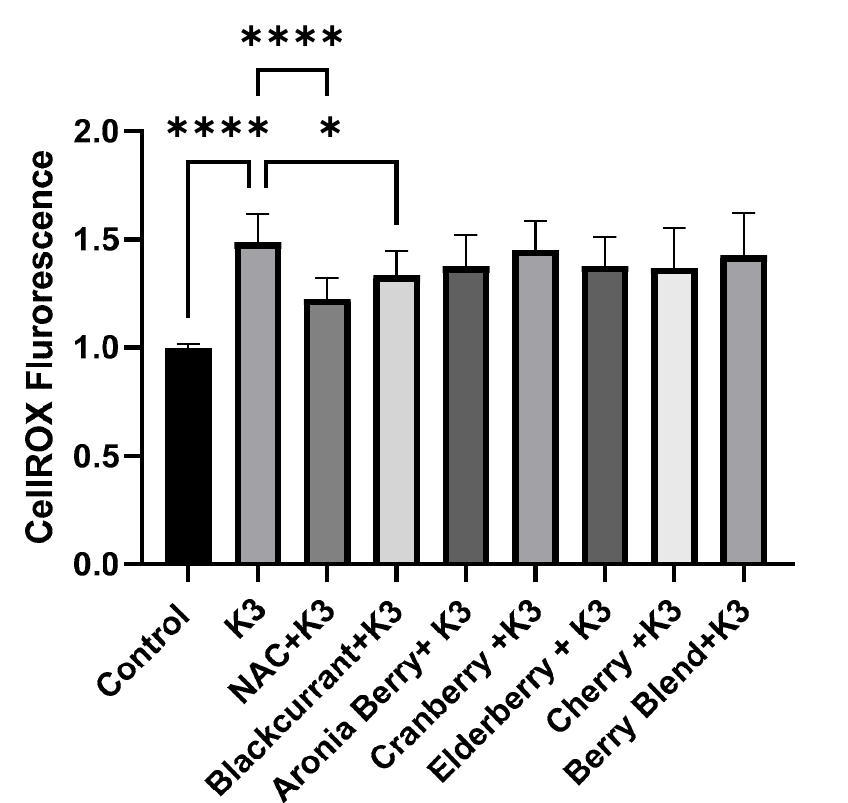
Figure 2. Effects of berry extracts (1 µ g/mL) on K3-induced oxidative stress in HL-1 cells. Mean normalized CellROX TM fluorescence from experiments ( n = 3) demonstrating the effect of berry extracts on menadione (Vitamin K3) induced oxidative stress in HL-1 cells. In each experiment, CellROX TM fluorescence was normalized to the Control. K3 (100 µ M) elicited a significant increase in CellROX TM fluorescence (**** p < 0.0001) indicating a marked increase in oxidative stress. The potent antioxidant N-acetylcysteine (NAC, 1 mM) significantly reduced K3-induced oxidative stress (**** p < 0.0001). Among the berry extracts, only black currant extract markedly inhibited oxidative stress (* p < 0.05).